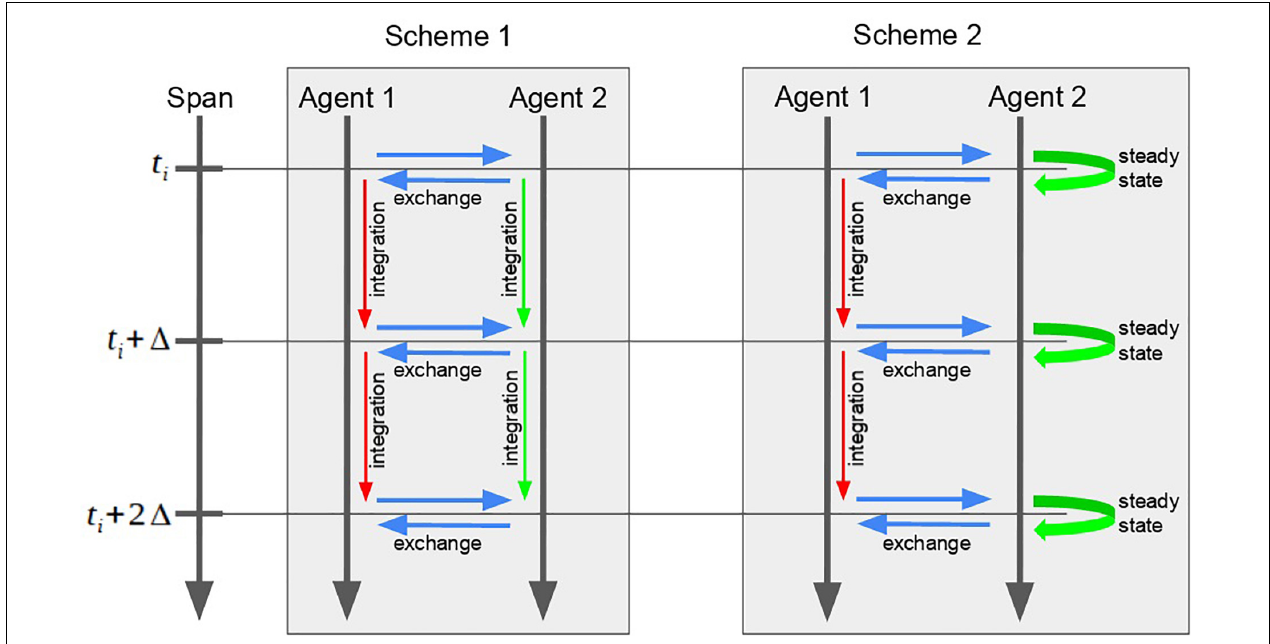
FIGURE 3 | Comparison between two schemes of the two-agent model simulation. The second scheme, instead of the long and unnecessary numerical calculations of the “fast” Agent 2, searches for the equilibrium at each point of the time span.